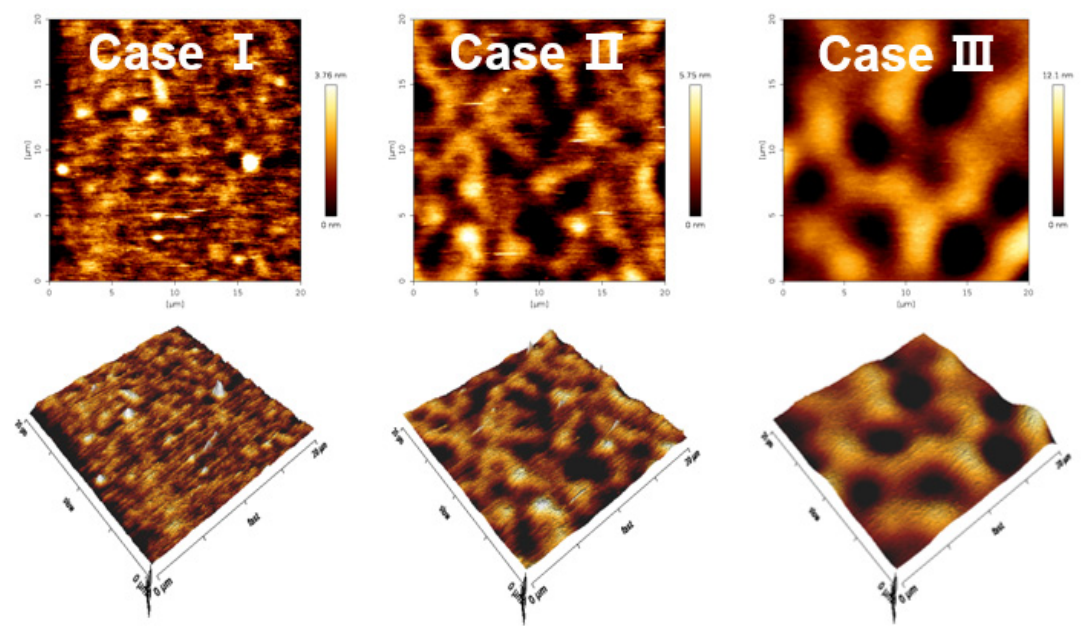
Figure 8. Two- and three-dimensional AFM images of PANI thin films prepared by APPR with pin electrode under optimal conditions with respect to three electrode configurations (cases I, II, and III). Table 3. Root mean square roughness (R rms ) and average roughness (R a ) of PANI thin films obtained from AFM images in Figure 8.